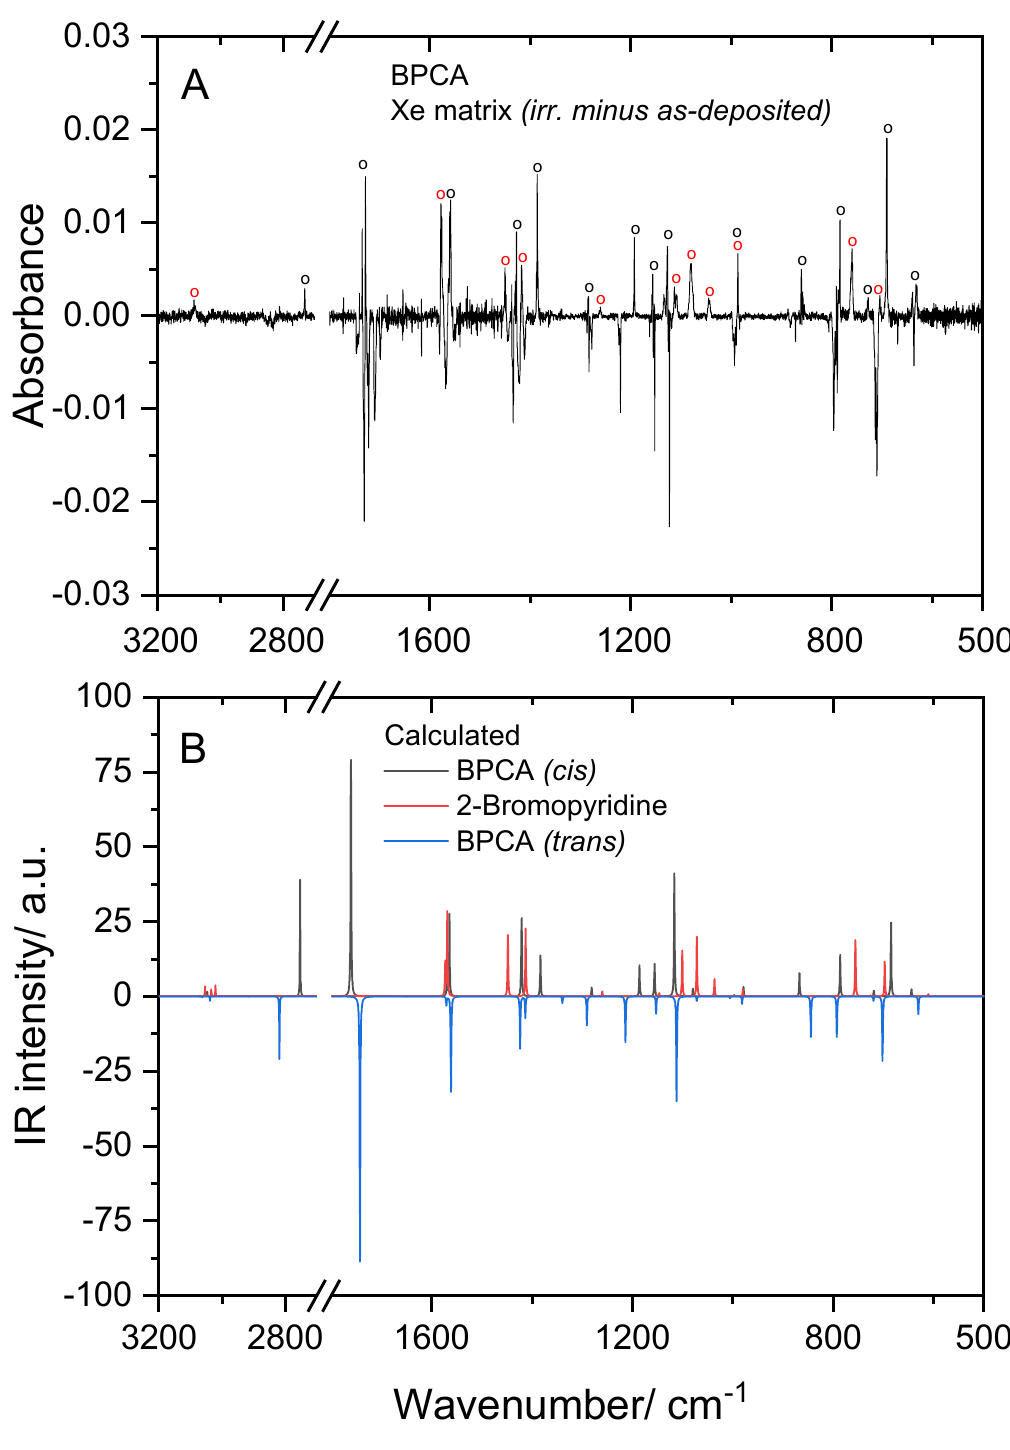
Figure 3. Experimental IR difference spectrum (UV-irradiated Xe matrix minus as-deposited matrix ( A ), and simulated IR spectrum built using the B3LYP/6-311++G(d,p) calculated vibrational data (frequencies were scaled as described in Section 3), with bands due to BPCA conformer cis and to 2-bromopyridine pointing up and bands due to BPCA conformer trans pointing down ( B ). The irradiation was performed at λ ≥ 235 nm for 180 min. Table 3. Assignment of the IR spectrum of the photoproduced cis conformer of BPCA in Ar, Kr and Xe matrices and calculated PEDs a .